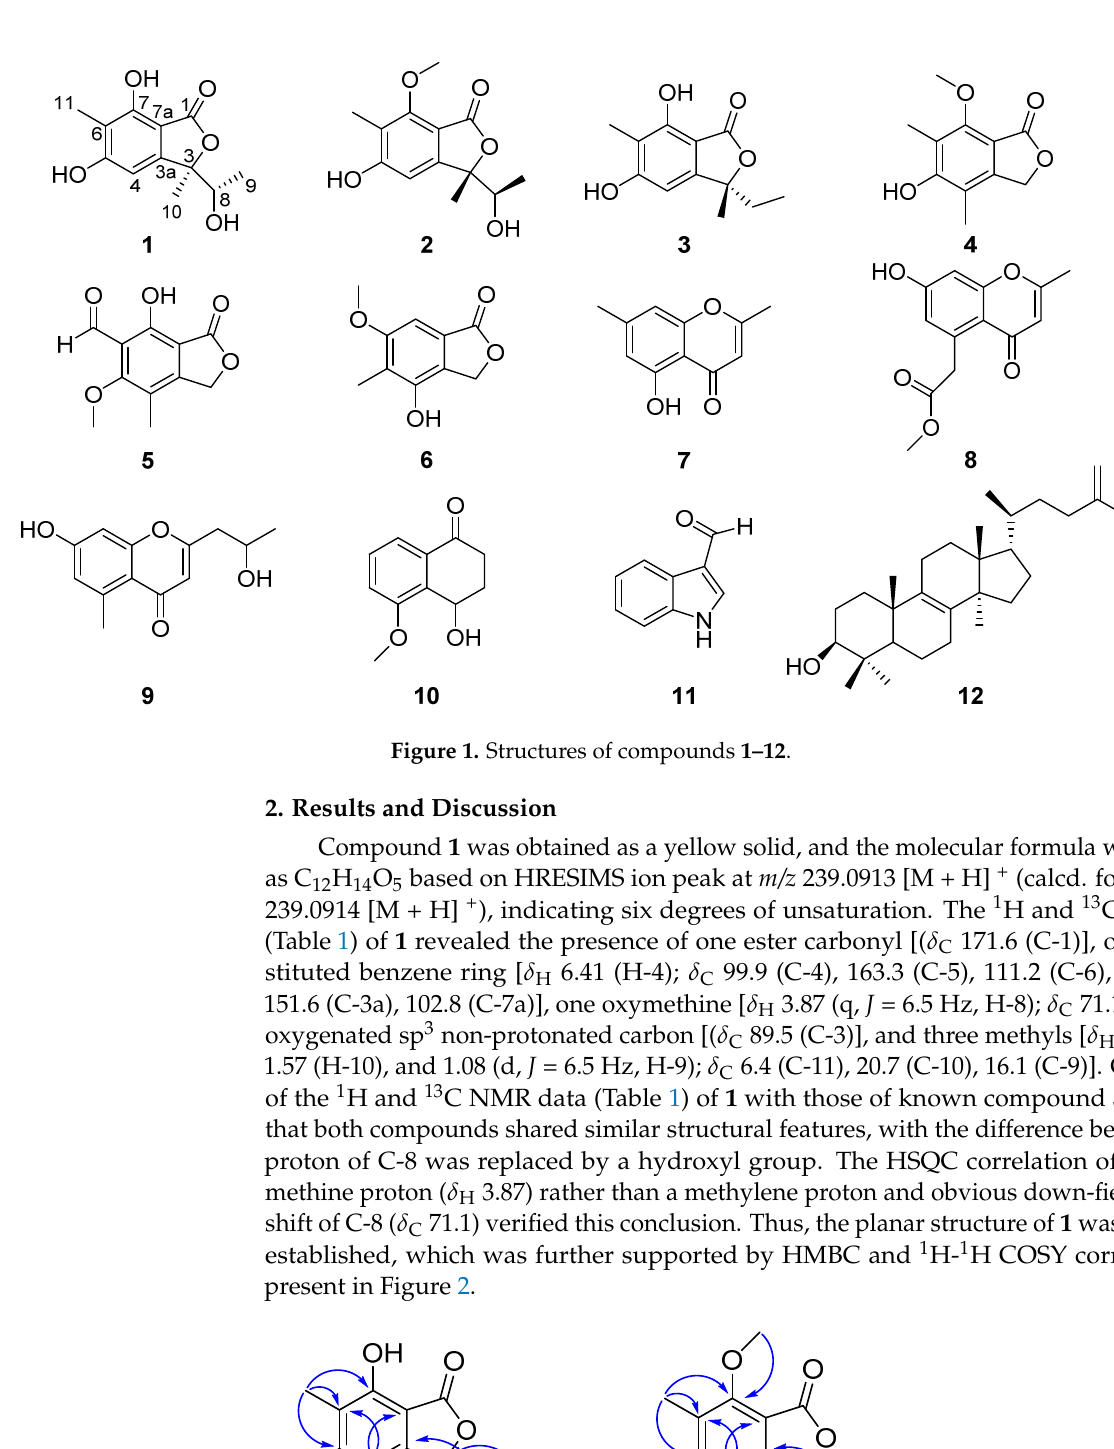
Figure 1. Structures of compounds 1–12 .